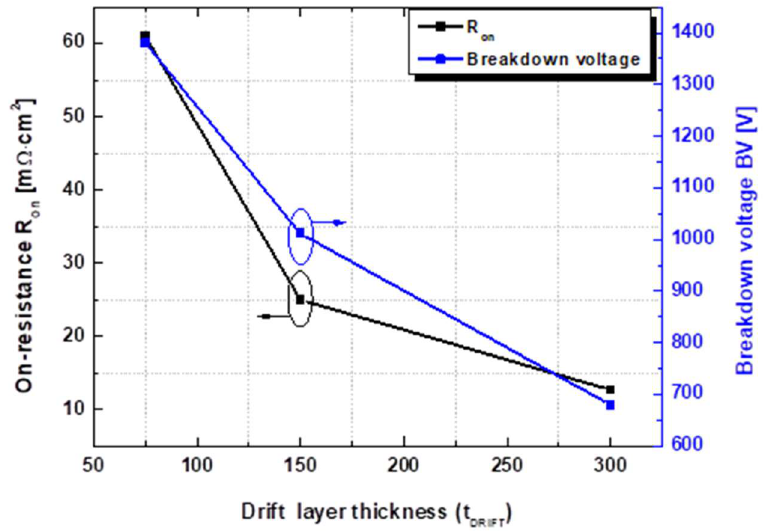
Figure 11. On-resistance and breakdown voltage characteristics as a function of drift layer thickness. The drift layer has a doping concentration of 3 × 10 17 cm −3 .